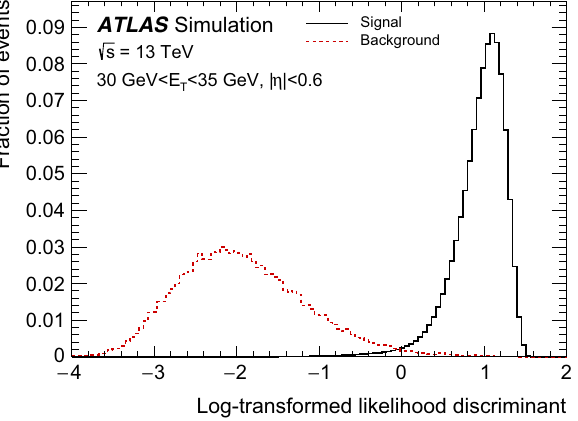
Fig. 5 The transformed LH-based identification discriminant d (cid:8) for reconstructed electron candidates with good quality tracks with 30 GeV < E T < 35 GeV and | η | < 0 . 6. The black histogram is for prompt electrons in a Z → ee simulation sample, and the red (dashed- line) histogram is for backgrounds in a generic two-to-two process sim- ulation sample (both simulation samples are described in Sect. 3). The histograms are normalised to unit